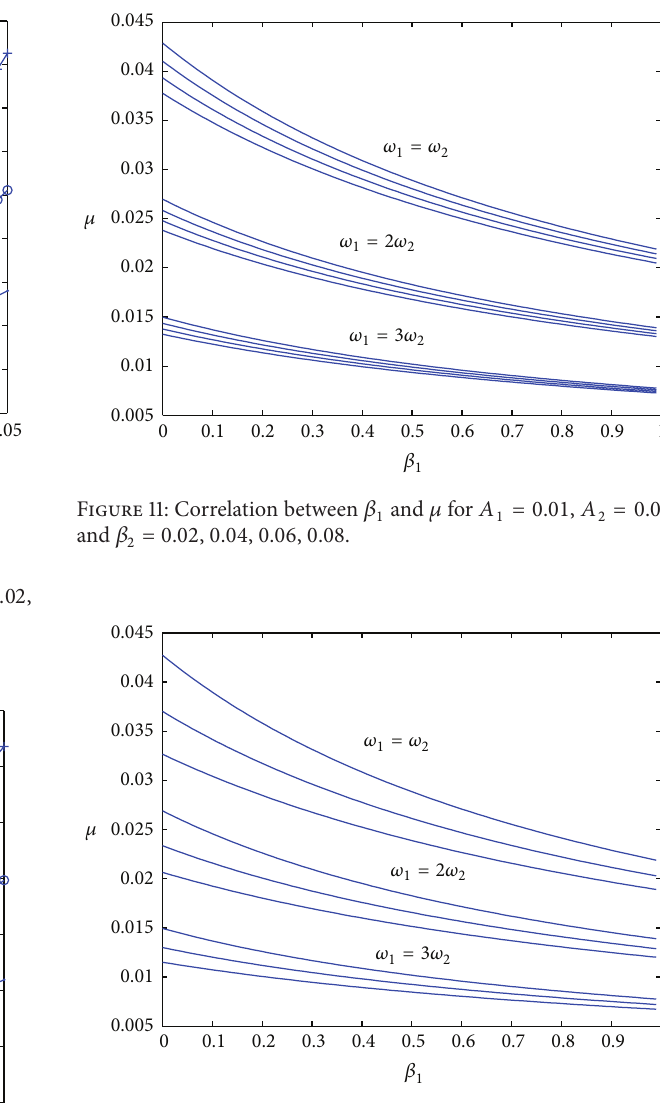
Figure 12: Combined figure between 𝜇 and 𝛽 1 ( 𝛽 2 = 0.01 , 𝐴 1 = = 0.01 , 0.02, 0.01 , and 𝐴 2